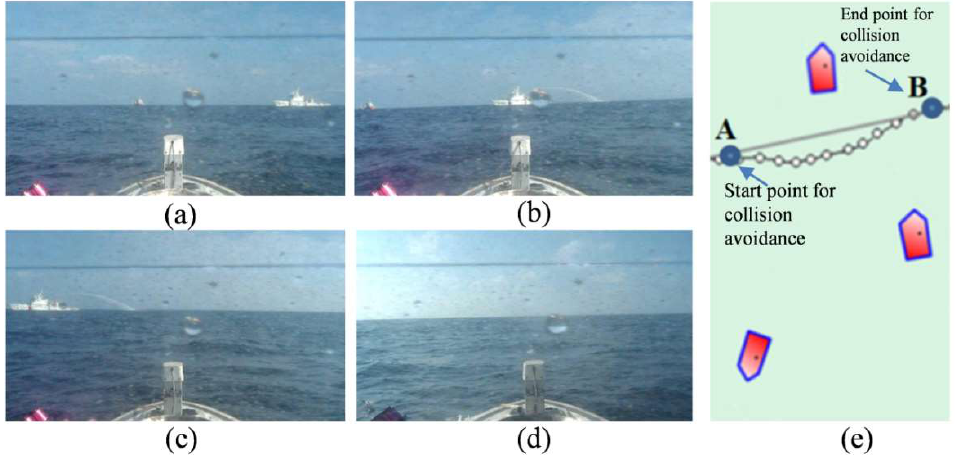
Figure 16. Process of the collision avoidance: ( a ) Start collision avoidance, ( b , c ) collision avoidance,